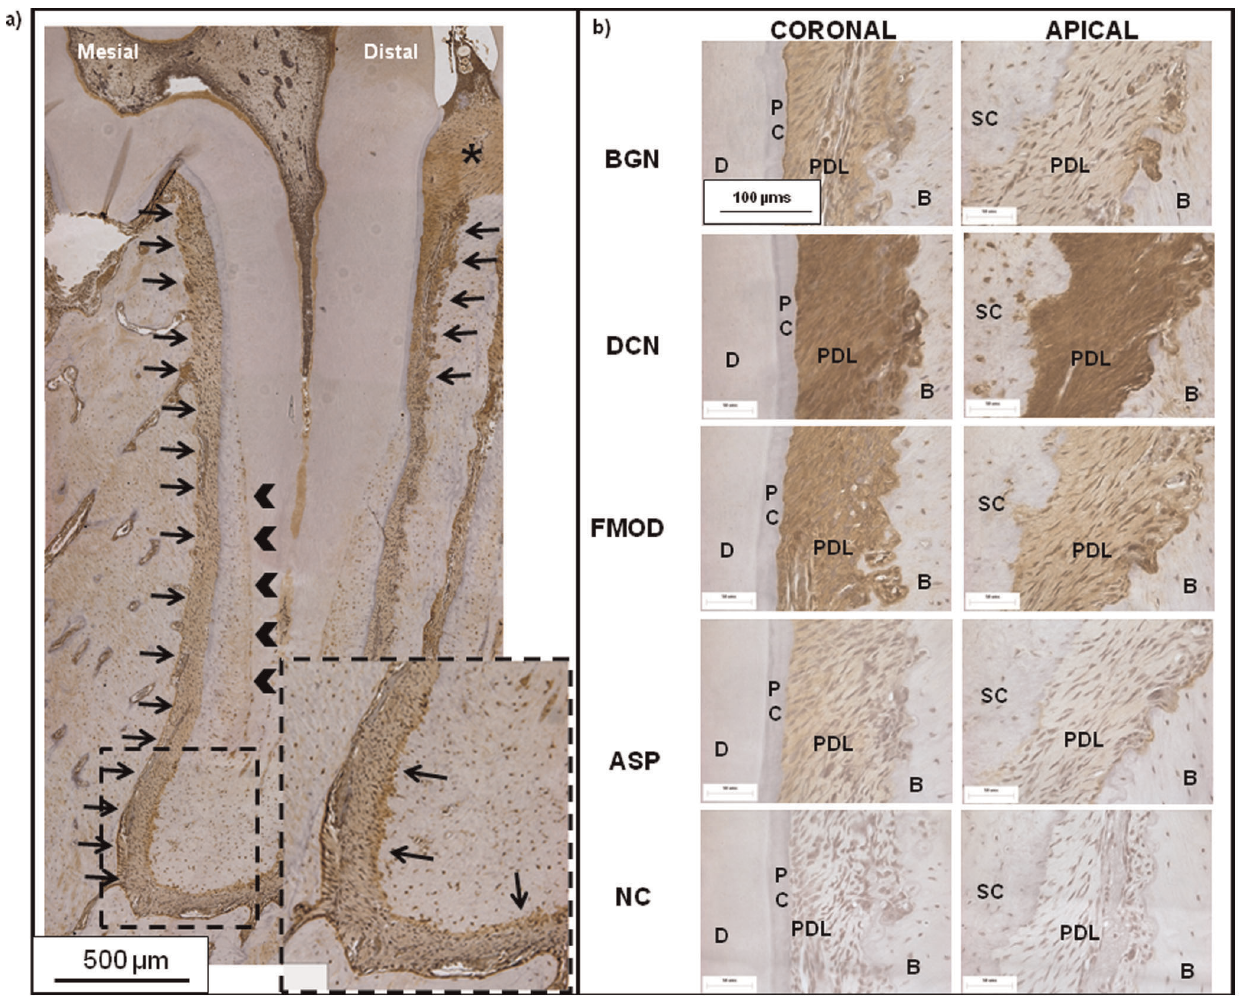
Figure 5. Immunohistochemical staining for identification of SLRPs. a) Light micrograph at 10X using immunohistochemical methods shows representative localization of SLRPs (biglycan expression in a 6 month old rat) counterstained with hematoxylin. Black arrows indicate localization at mesial PDL-bone enthesis spanning the root length as well as the coronal predominance. In addition localization was also observed in precementum layers (black arrow heads, in Fig. 5a) and at the CDJ (black arrow in inset, Fig. 5a), predentin, and the transseptal fibers (asterisk, Fig. 5a) between any two molars. Scale bars=500 m m. b) Serially sectioned 60X light micrographs show immunohistochemical localization of SLRPs: biglycan (BGN), decorin (DCN), fibromodulin (FMOD), asporin (ASP), and negative controls (NC). Localization indicates more intense staining in coronal regions relative to apical regions across all age groups. All micrographs indicate regions where PDL meets primary bone (B) and primary cementum (PC) or secondary cementum (SC), with adjacent dentin (D). All Scale bars=100 m